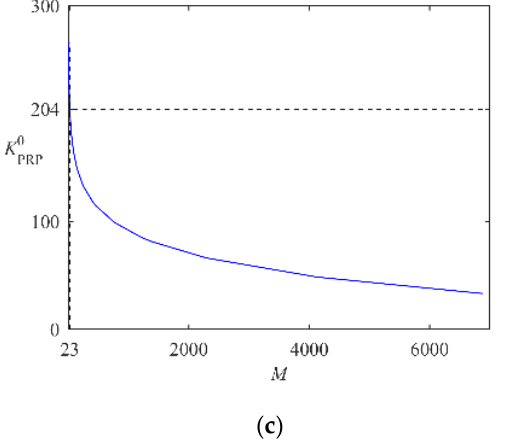
Figure 7. Analysis of the change of the lowest projection dimensionality K 0 PRP with different parameters. ( a ) The change curve of ε and K 0 PRP . (The position of the black dotted line is the inflection point.) ( b ) The change curve of β and K 0 PRP . ( c ) The change curve of M and K 0 PRP . (The position of the black dotted line is the number of bands).